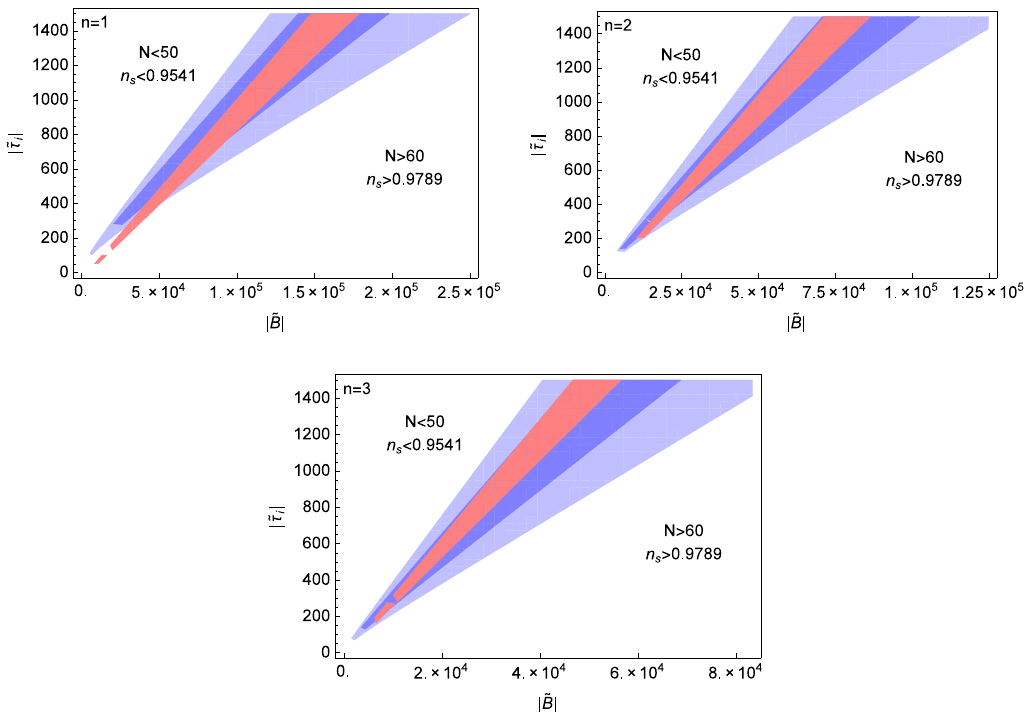
Figure 5 . n s and N on ( ~ B; ~ (cid:28) i )-plane for A < 0 and n = 1 ; 2 ; and